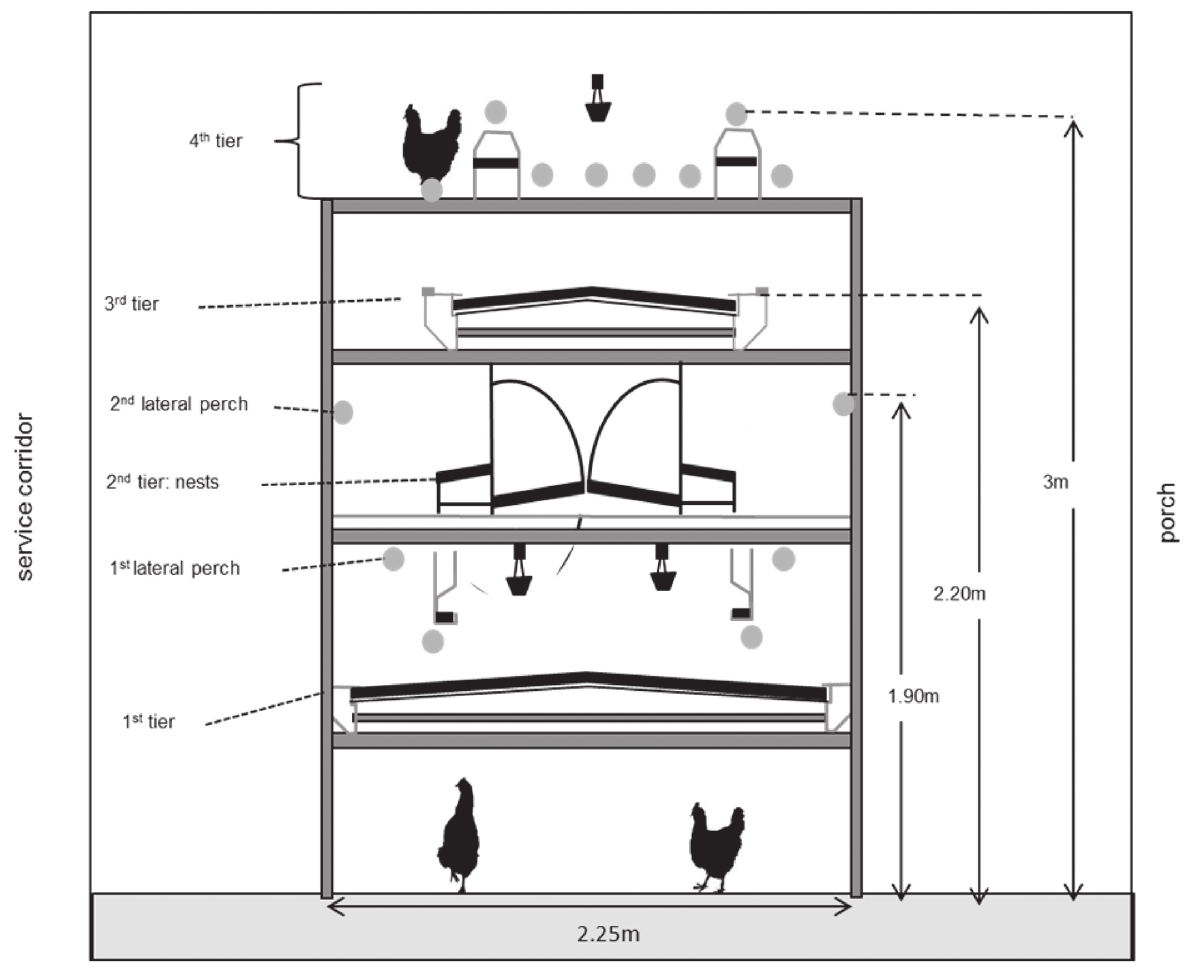
Fig 1. Schematic side view of aviary system Bolegg